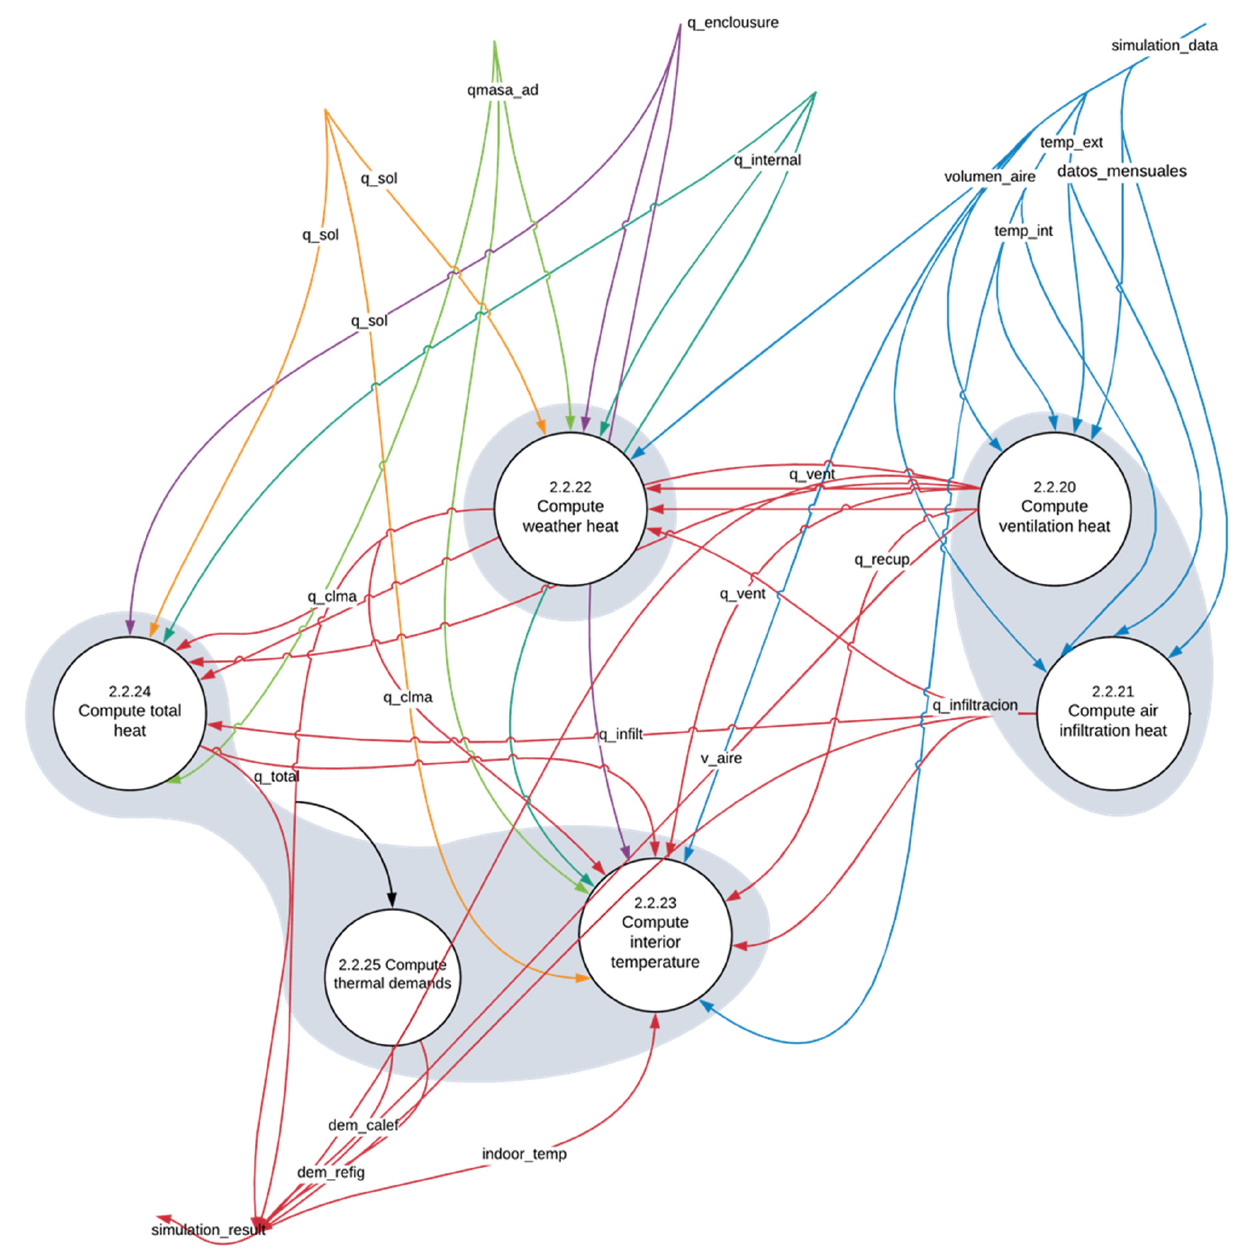
Figure 8. Third step of the energy demand calculation process. Algorithm 10 contains two sub-processes. Process 2.2.21 calculates the heat infiltration in the indoor air of the evaluated dwelling, and process 2.2.20 represents the heat-to-air-flow rate needed to achieve the air renewals necessary for health.